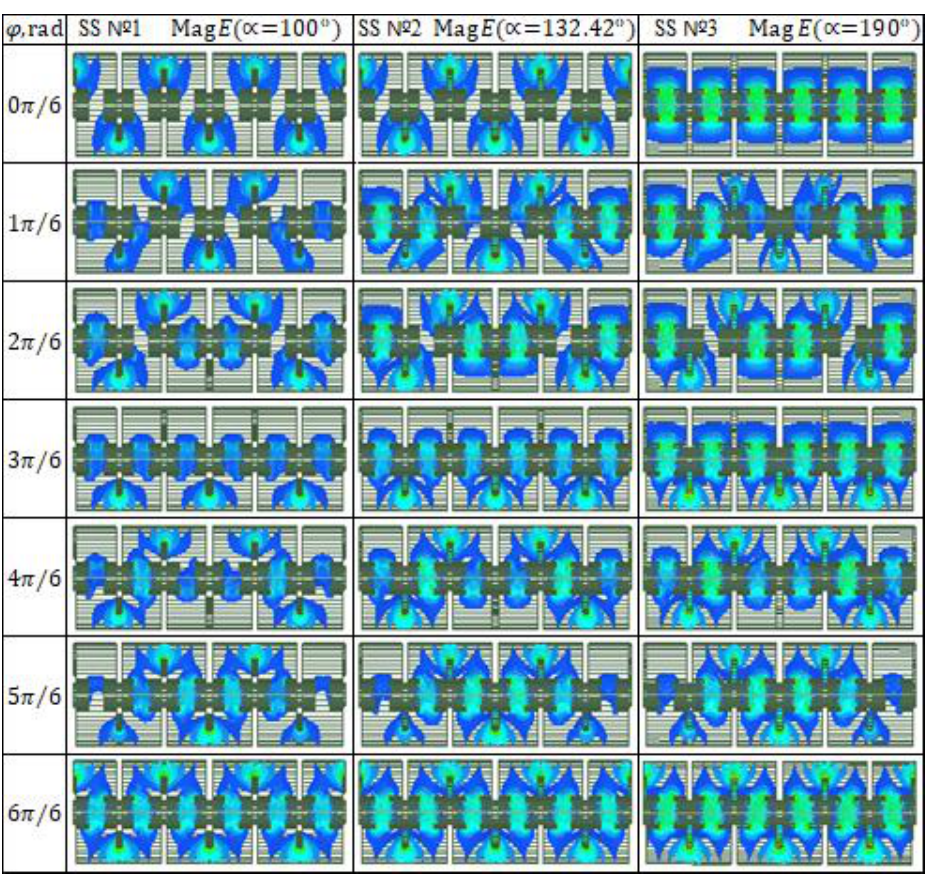
Fig. 5. The distribution of the electric field in resonance modes in the high-frequency passband SS